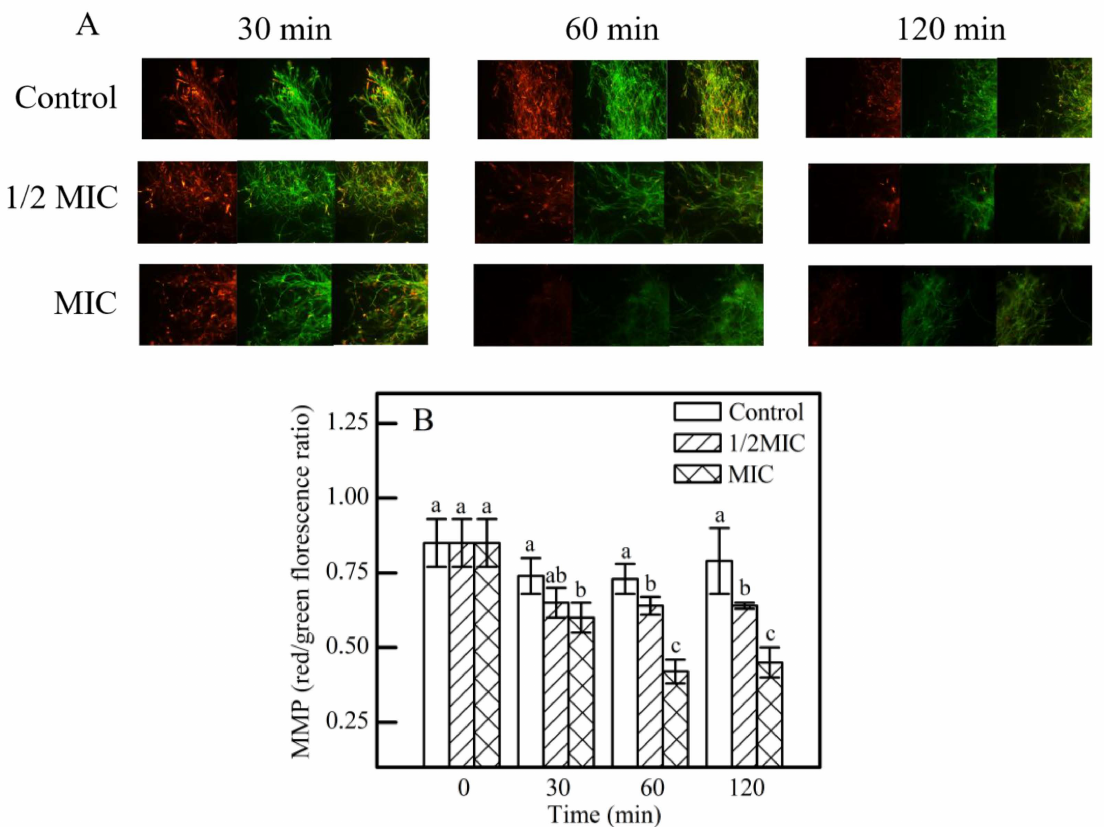
Figure 9. Effect of γ -CDCL on the MMP of P. digitatum mycelia. ( A ) Fluorescence images of different treatment concentrations (Control; 1/2 × MIC; 1 × MIC) for 30, 60, 120 min; ( B ) Mycelia fluores- cence fold changes. Data are expressed as the means ± standard deviation of pooled data ( n = 3, p < 0.05). γ -CDCL, cinnamaldehyde/ γ -cyclodextrin inclusion complex; MMP, mitochondrial mem- brane potential; MIC, minimum inhibitory concentration. Dissimilar lowercase letters in the his- togram express the statistical significance among different treatments at the same